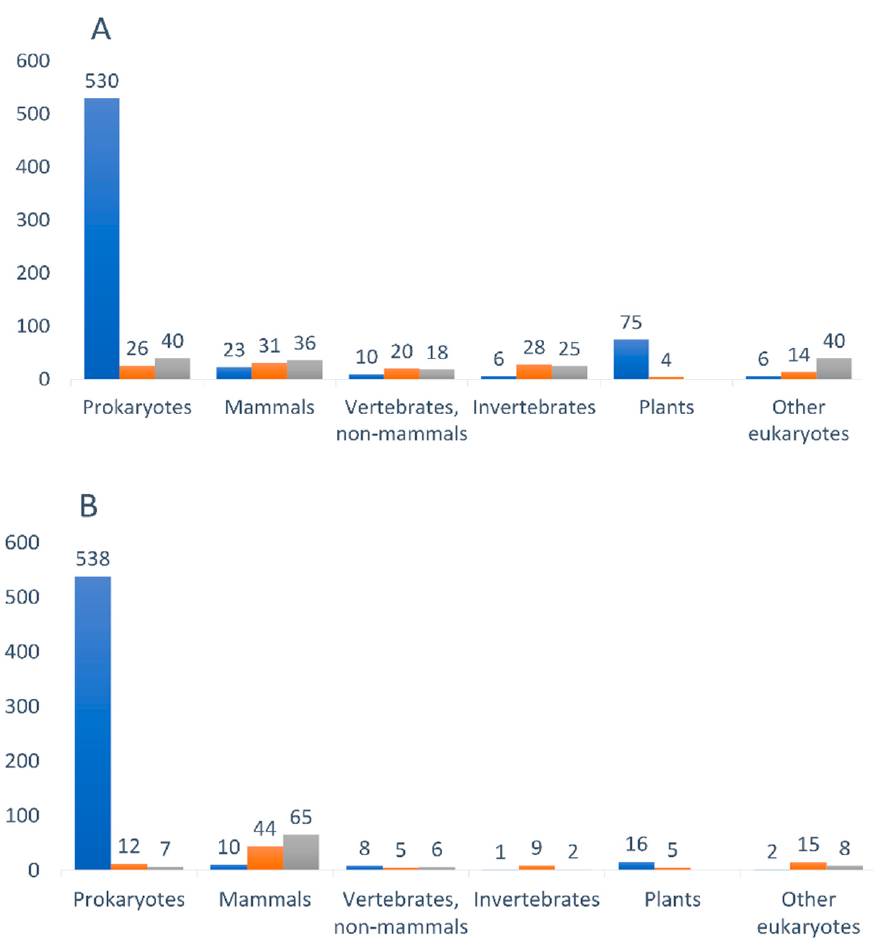
Figure 3. Diagram representations of taxonomic distribution of genes encoding proteins, which were retrieved from an UniProtKB database as aligned with ( A ) AFP 14–20 and ( B ) GIP-9 segment of human AFP. Amounts of unique genes in each taxonomic category are shown above each column. Prokaryotes—bacteria (blue), viruses (brown), archaea (grey); mammals— Homo sapiens (blue), pri- mates (brown), other mammals (grey); vertebrates—birds (blue), fishes (brown), amphibia (grey); invertebrates—reptiles (blue), insects (brown), nematodes (grey); plants—higher plants (blue), algae (brown); other eukaryotes— S. cerevisiae (blue), fungi (brown), mollusks, scorpions, spiders, etc., (grey).